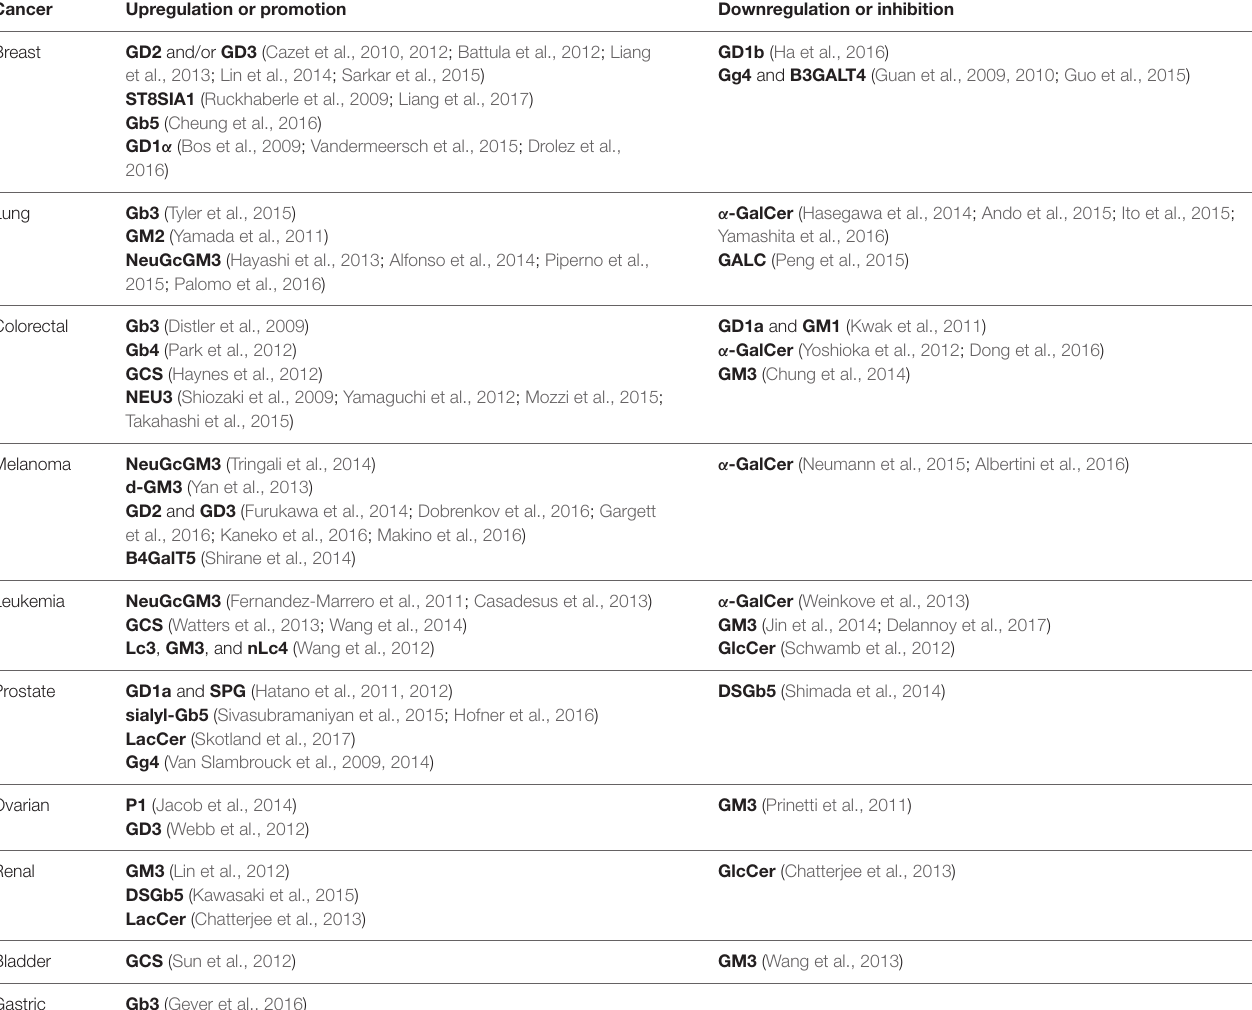
TABLE 1 | Glycosphingolipids and related enzymes aberrantly expressed in various types of cancer. Cancer Upregulation or promotion Downregulation or